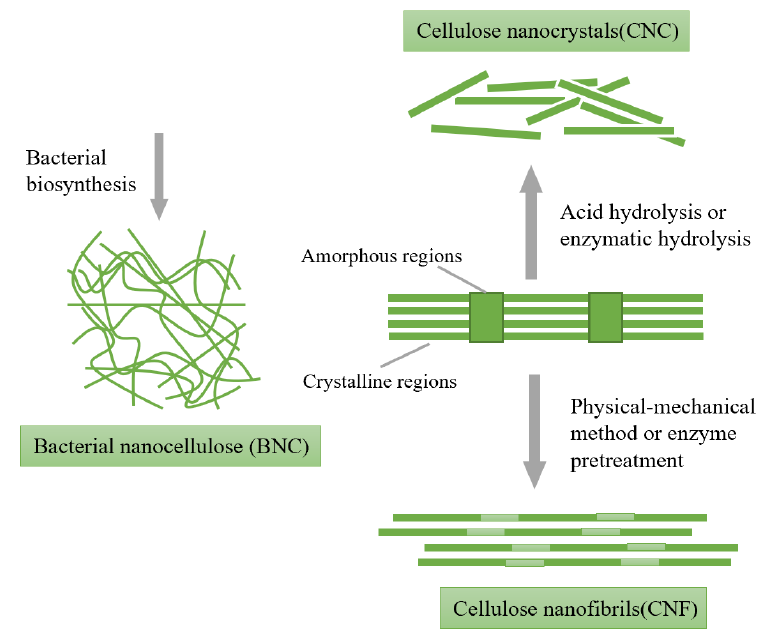
Figure 6. Different types of nanocelluloses: nanocrystalline cellulose, nanofibril cellulose and bacterial nanocellulose. Data reproduced from ref. [61] .